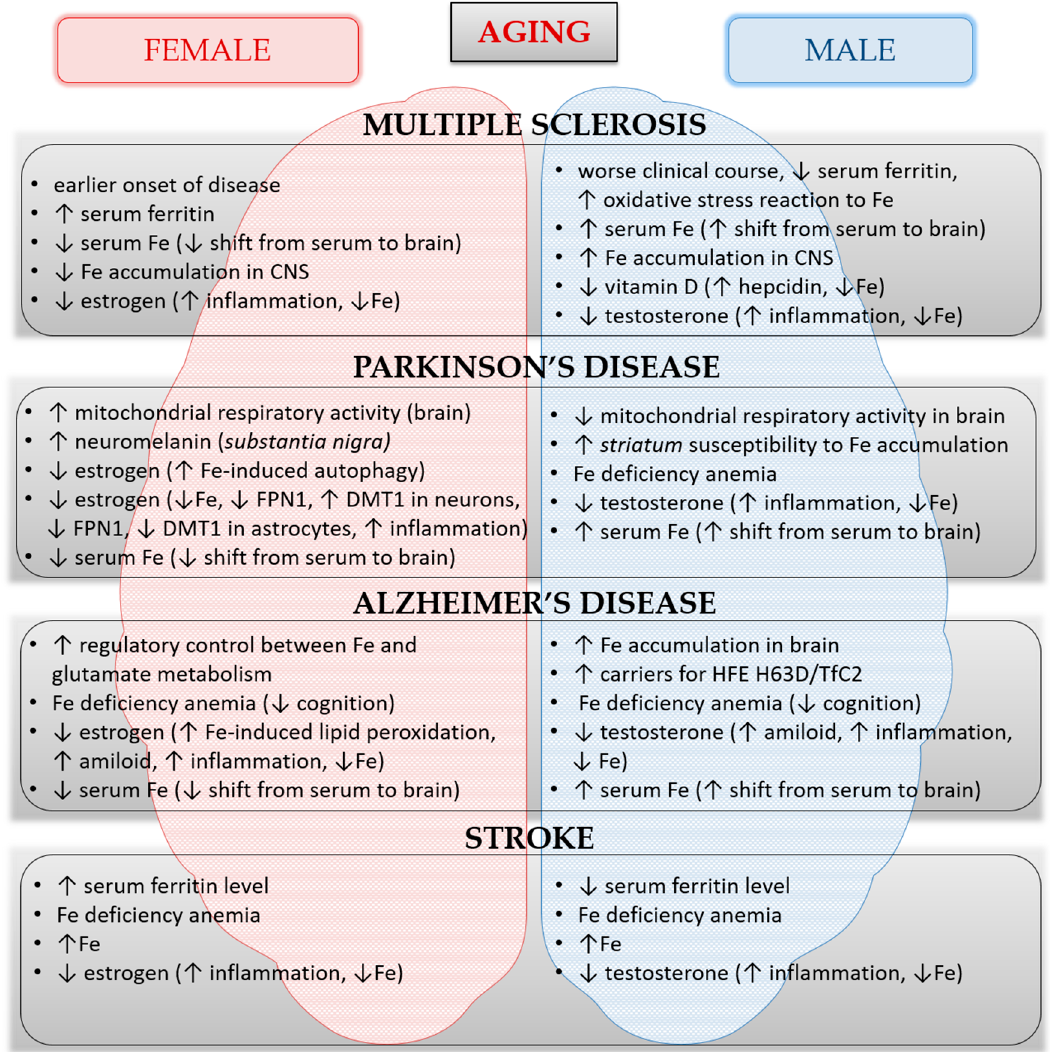
Figure 3. The summary of features that involve iron impact on increased susceptibility to certain neurological disorders or increased progression of already present disorders in males and females during aging. The summary includes data from the references in this review. Abbreviations